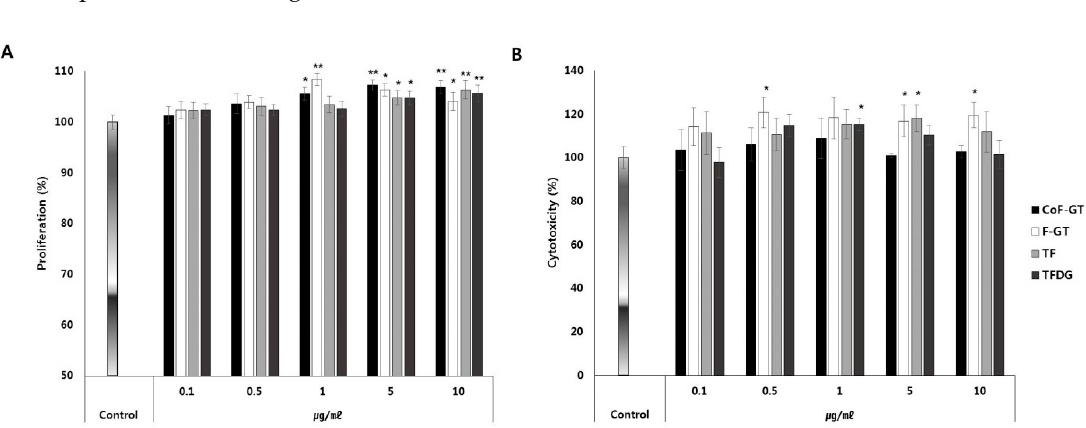
Figure 2. Effect of TF on human subcutaneous fat cells (hSCFs) viability. ( A , B ) Proliferation ( A ) and cytotoxicity ( B ) were evaluated 24 and 72 h after treatment, respectively. Data are presented as mean ± standard deviation (SD). * p < 0.05, ** p < 0.01.